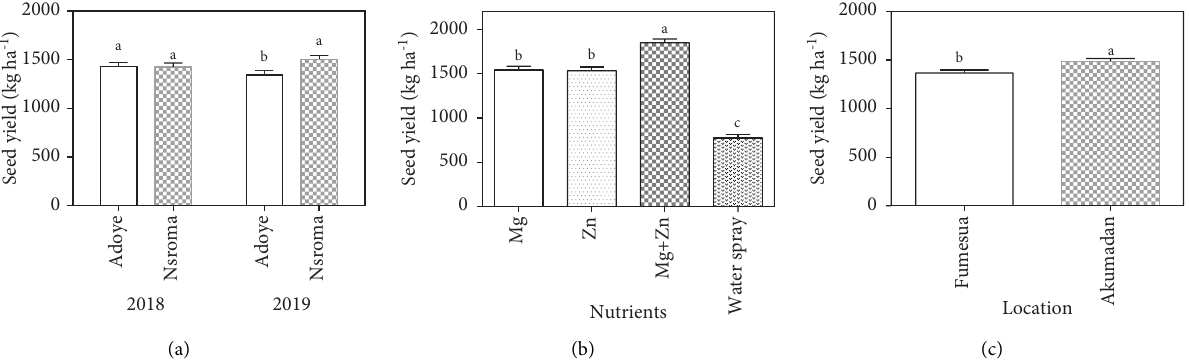
Figure 4: Impact of treatment on seed yield. Bars with different letters in the figure are statistically different at P < 0 . 05. Error bars represent the standard error of means. Means comparison was done using Tukey HSD (honestly significant difference) ( P < 0 . 05). Table 4: Relationships between pods per plant (PP), seeds per pod (SP), biomass yield (BY), plant height (PH), leaf chlorophyll content (SPAD), and stomatal conductance (GS).